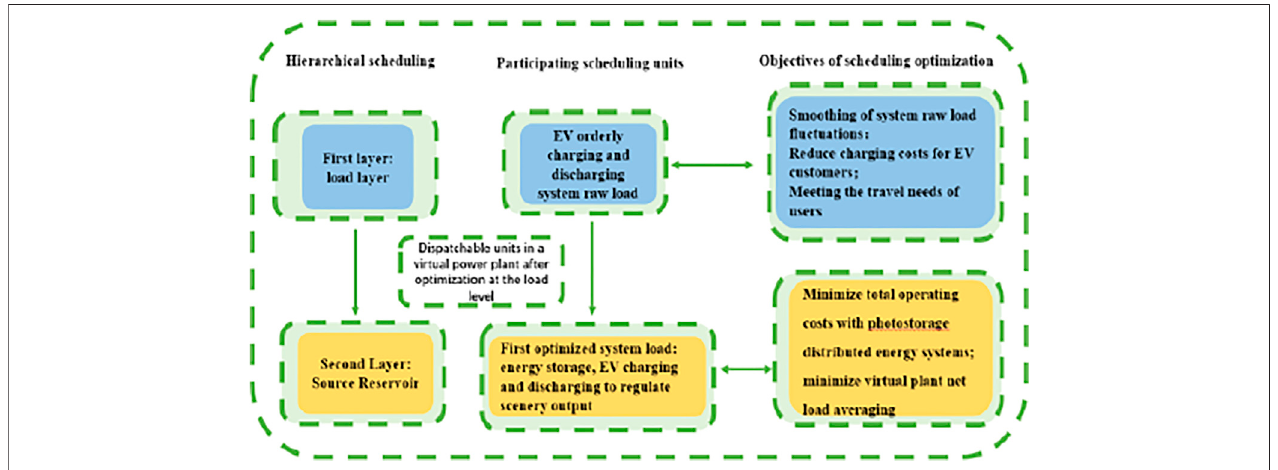
FIGURE 5 | Tiered scheduling optimization strategy for distributed energy system considering customer